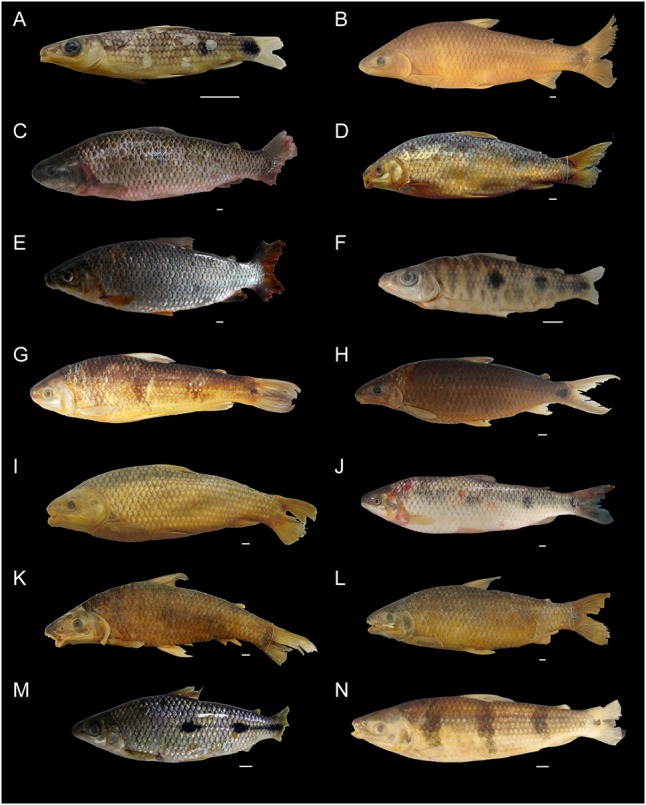
Studied specimens of Megaleporinus. (A)
M. brinco, MZUSP 118670; (B)
M. cf. conirostris, LISDEBE 6971; (C)
M. cf. muyscorum; (D)
M. cf. obtusidens Paraguay, MZUSP 118668; (E)
M. cf. obtusidens São Francisco, MCP 44805; (F)
M. cf. reinhardti, UESB-8206; (G)
M. cf. trifasciatus, GEPEMA 5095; (H)
M. garmani, MCNI-PUCMG-0020; (I)
M. macrocephalus, MZUSP 118667; (J)
M. muyscorum, ICN-19074; (K)
M. obtusidens, MZUSP 113982; (L)
M. piavussu, MZUSP 113981; (M)
M. reinhardti; (N)
M. trifasciatus, MUSM – 47351. Scale bars equal 1 cm.